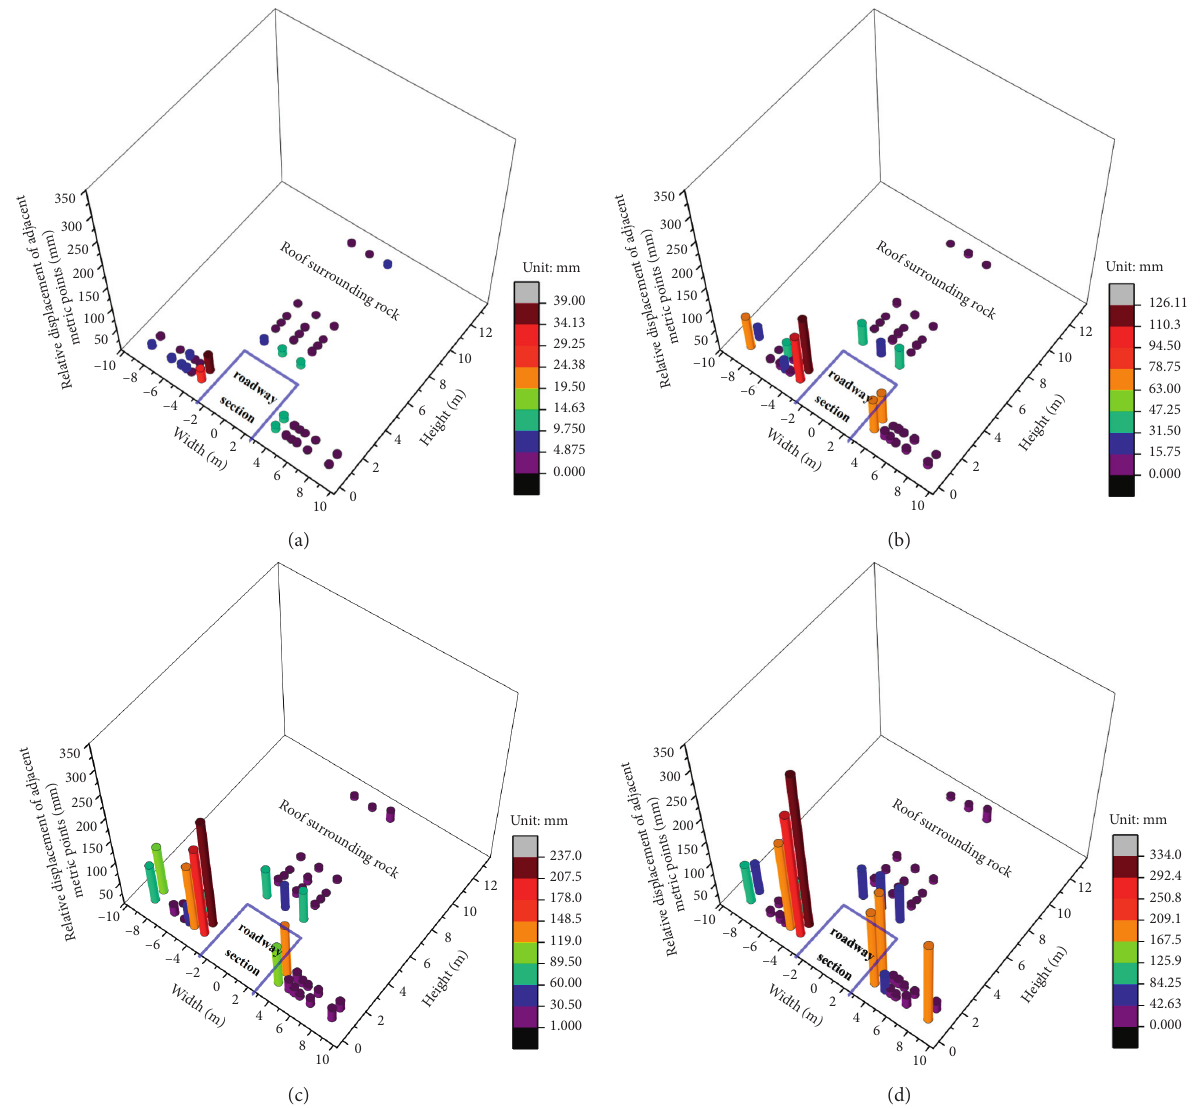
Figure 9: Monitoring results from displacement meters at station #2: (a) 130m from the longwall face; (b) 90m from the longwall face; (c) 50m from the longwall face; (d) 10m from the longwall